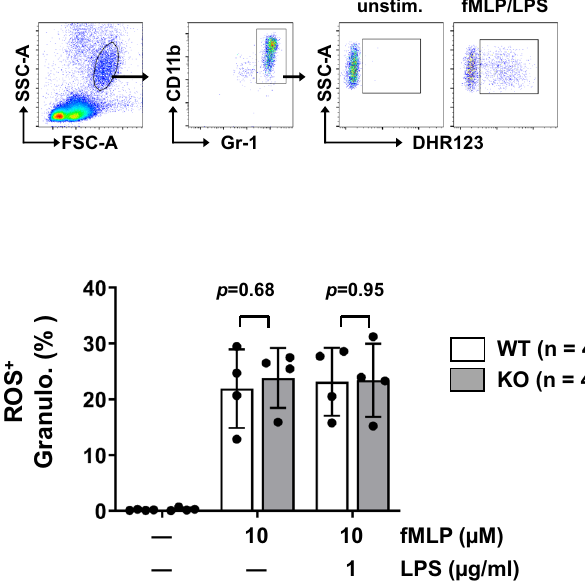
Fig. 2 Production of reactive oxygen species (ROS) by granulocytes. Blood granulocytes from our Fcmr KO and WT C57BL/6 female mice of 8 – 12 weeks of age were loaded with 10 µ M dihydrorhodamine 123 (DHR123), stimulated with or without 10 µ M N -formyl-methionine-leucine- phenylalanine (fMLP) in the presence or absence of lipopolysaccharide (LPS; 1 µ g/ml), and stained with PE-labeled Gr-1 and PE/Cy7-labeled CD11b mAbs, before lysis of erythrocytes and fl ow cytometric analysis. Top: Gating strategy for DHR123 + Gr-1 + CD11b + ROS-producing granulocytes. Bottom: Results are shown in mean ± 1 SD, n = 4 P values were calculated with an unpaired Student t- test and a two-tailed P value of <0.05 was statistically signi fi cant. Note comparable ROS production between our Fcmr KO and WT mice, distinct from enhanced ROS production by their Fcmr KO granulocytes 6